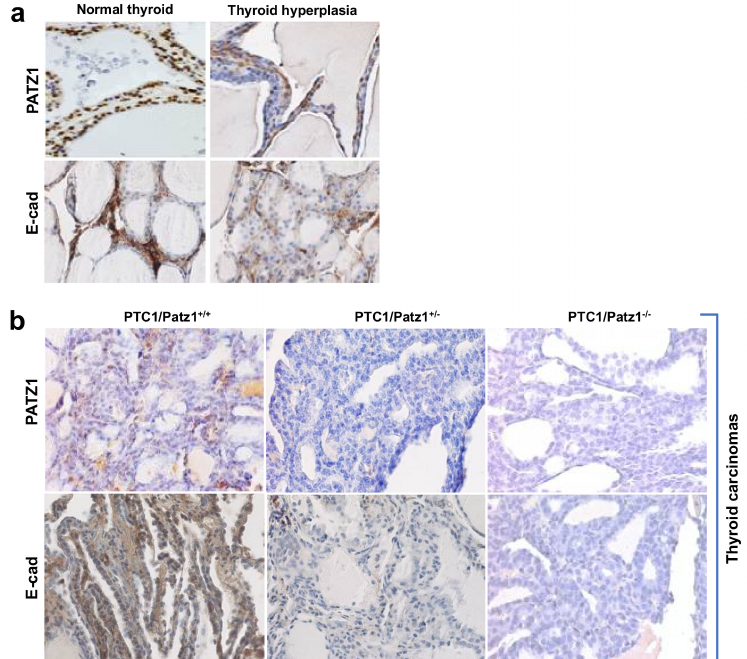
Figure 5. Representative mouse thyroid samples immunostained for PATZ1 and E-cadherin. ( a ) normal and hyperplastic thyroids show positive immunostaining for both PATZ1 and E-cadherin; ( b ) thyroid carcinomas from RET/PTC1 TG ;Patz1 +/+ , RET/PTC1 TG ;Patz1 +/ − , and RET/PTC1 TG ;Patz1 − / − mice stained for PATZ1 and E-cadherin. Original magnification: ×